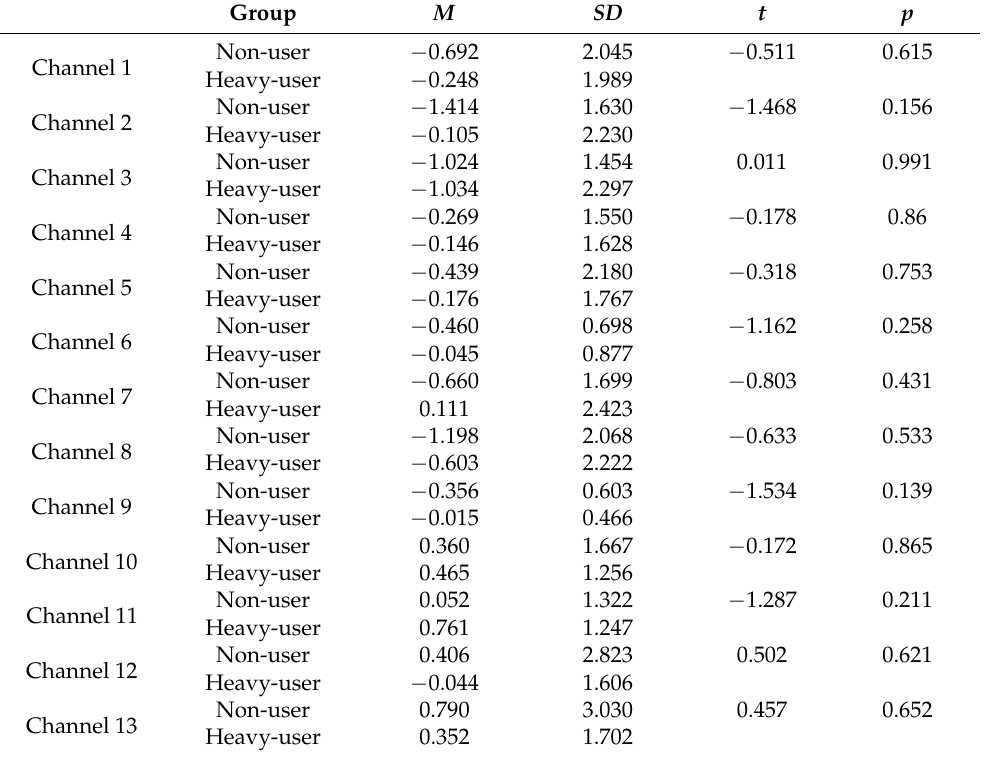
Table 2. Comparison of HbO increase between ‘non-user’ (N 1 = 8) and ‘heavy-user’ (N 2 = 16)